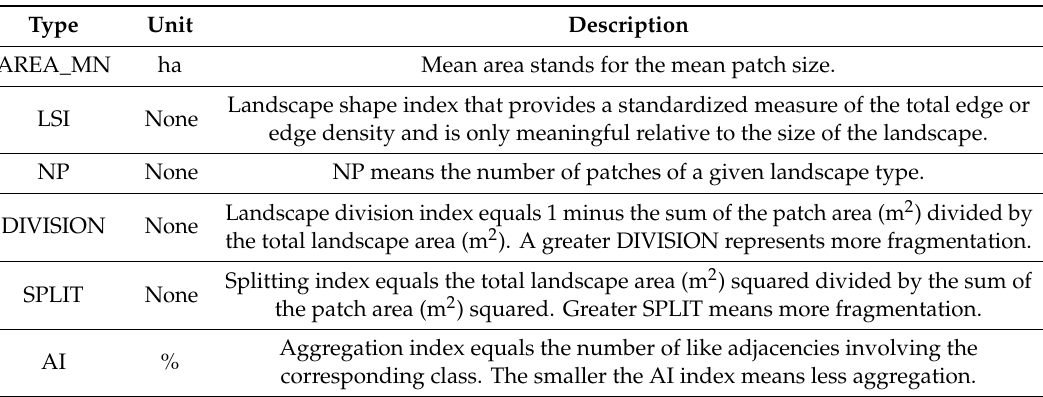
Table 1. The landscape metrics.